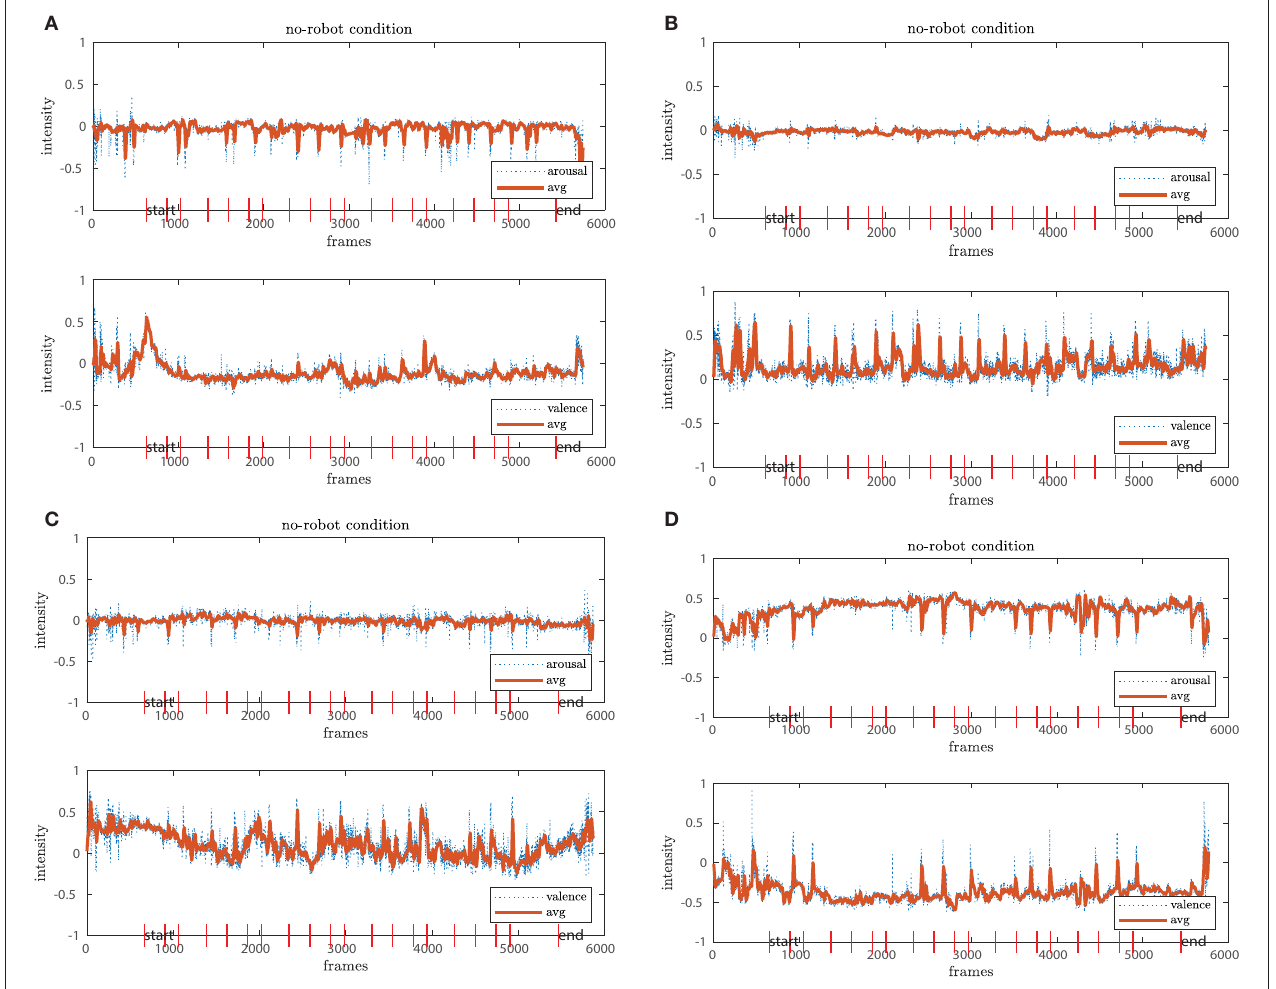
FIGURE 7 | Representative temporal profiles of the arousal-valence progress in the no-robot condition. While the arousal state remains stable (A–D , upper plot ) , the valence dimension fluctuates for some of the participants, mostly in agreement with task onsets (B–D)